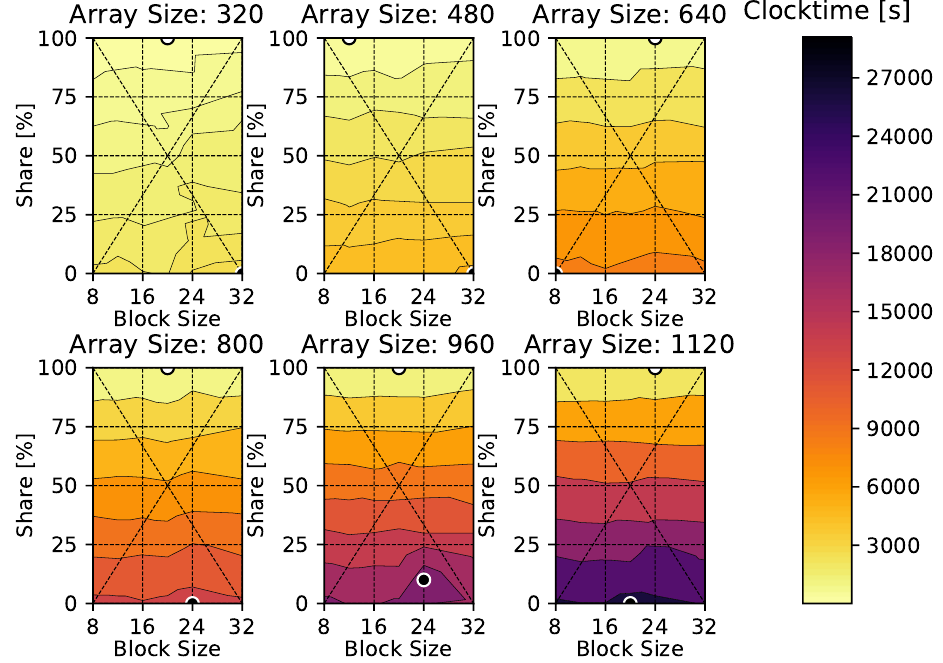
Figure 12. Clock time results for the compressible Euler equations with GeForce GTX 1080 Ti GPUs and Intel Skylake Silver 4114